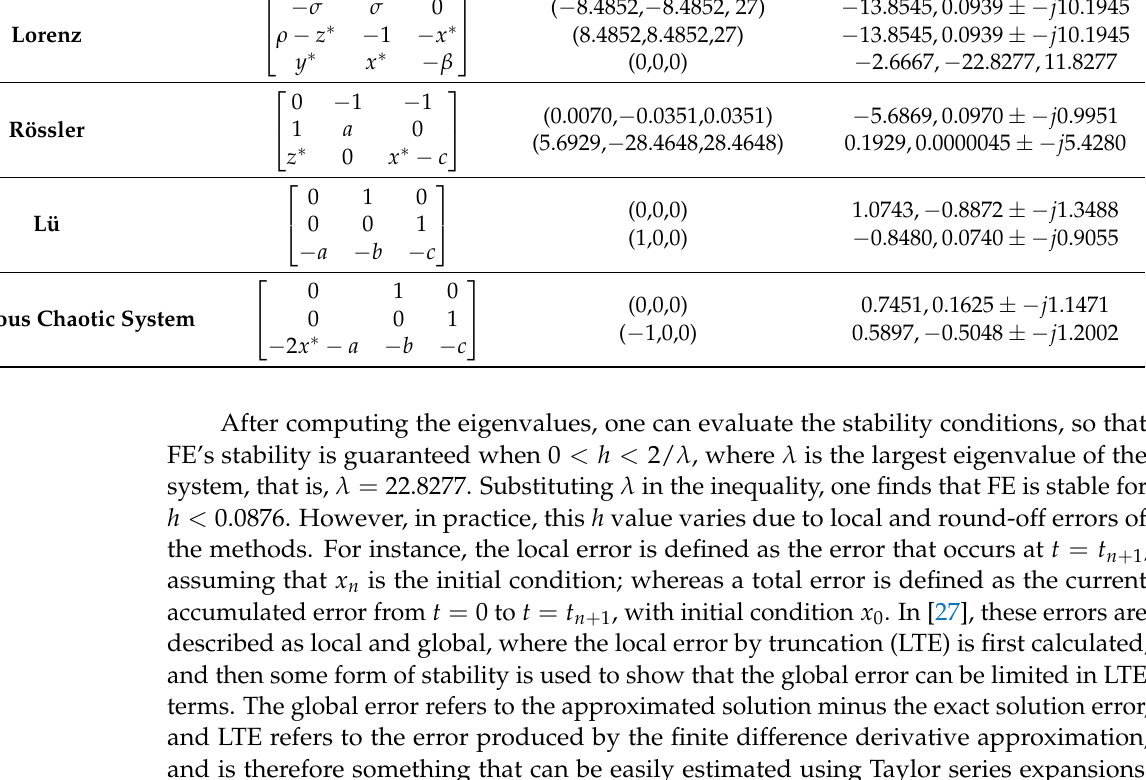
Table 3. Jacobian, Equilibrium points, and Eigenvalues of the chaotic systems given in (1)–(5). System Jacobian Equilibrium Points Eigenvalues